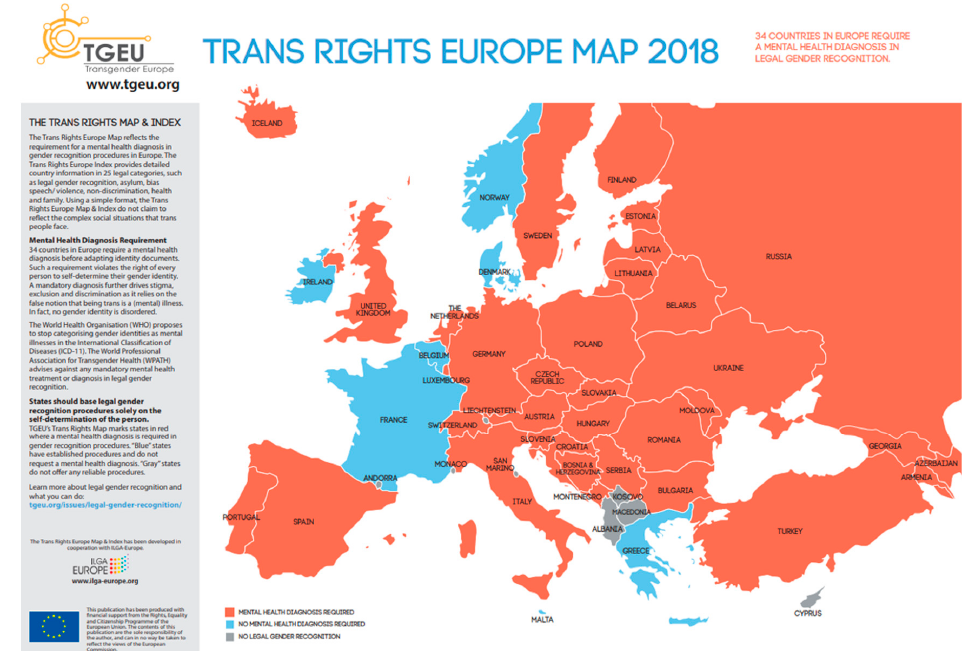
Figure 1. Trans Rights Europe Map (source tgeu.org)